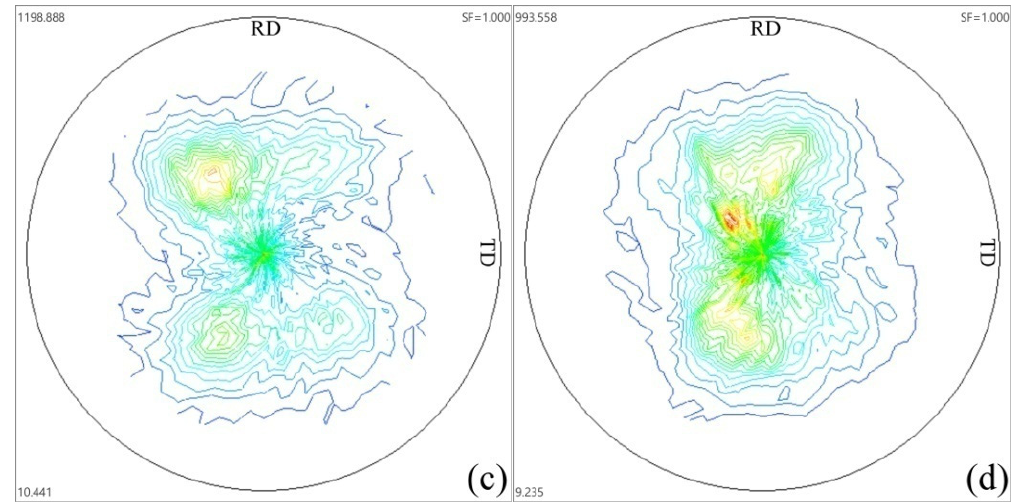
Figure 5. Pole figure detected by XRD in AZ31 alloys HSRMFed at different temperatures as Δε = 1.32: ( a ) 250 °C, ( b ) 300 °C, ( c ) 350 °C, ( d ) 400 °C.